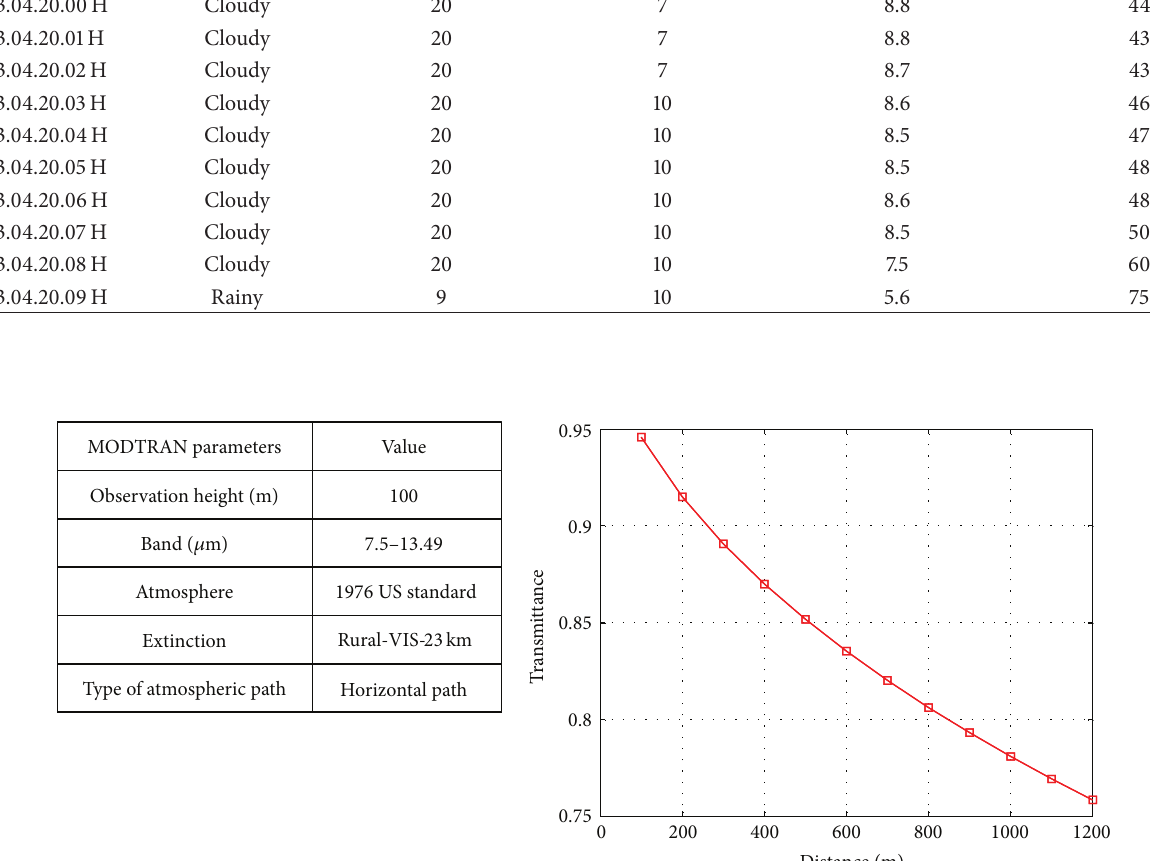
and SCR values can be derived based on these three key parameters. Figure 10 shows the flow of the SCR computation of a test image. The test image was obtained from 14-bit raw data and the bright spot represents a gas heater (Figure 10(a)). SNR enhanced image can be obtained by applying a matched